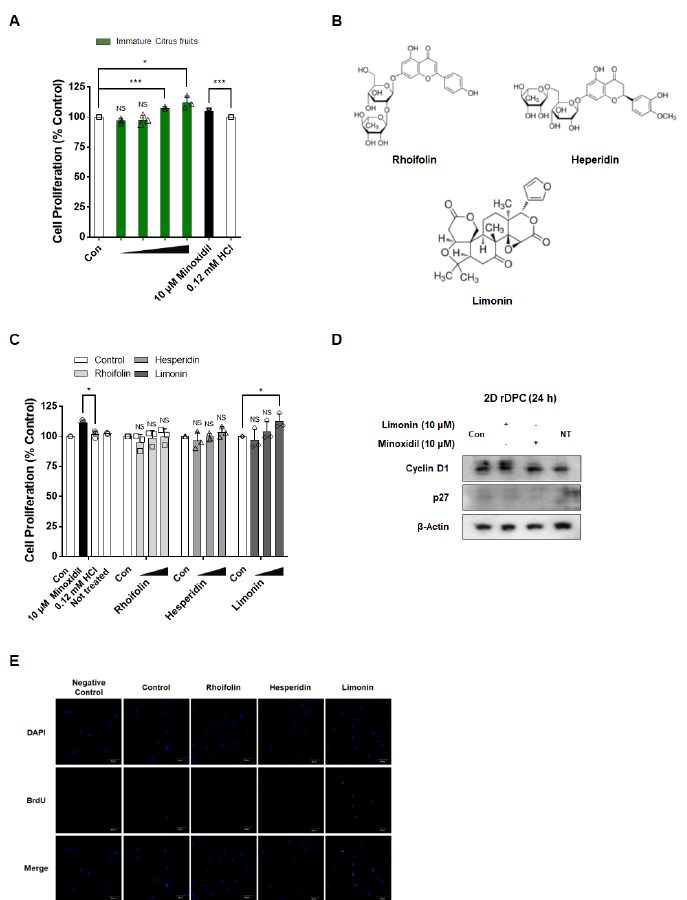
Figure 1. Limonin, a component of immature citrus fruits, induces the proliferation of two-dimensional (2D) rDPC. ( A ) Effects of immature citrus fruit peel extract on the proliferation of 2D rDPC. ( B ) Structure of the components (rhoifolin, hesperidin, and limonin) from immature citrus fruits. ( C ) Effects of rhoifolin, hesperidin, and limonin on the proliferation of 2D rDPC. ( D ) Representative images of Western blots for cell cycle-related proteins cyclin D1 and p27 after treatment with limonin and minoxidil for 24 h. ( E ) Confocal microscopy images for changes in the number of BrdU-positive cells after treatment with rhoifolin, hesperidin, and limonin for 24 h. Data are presented as the mean ± standard deviation of three independent experiments. * p < 0.05, *** p < 0.001 vs. vehicle-treated control. Scale bars, 50 μ m. Con, vehicle-treated control; 0.12 mM HCl, vehicle for minoxidil; NS, not significant.